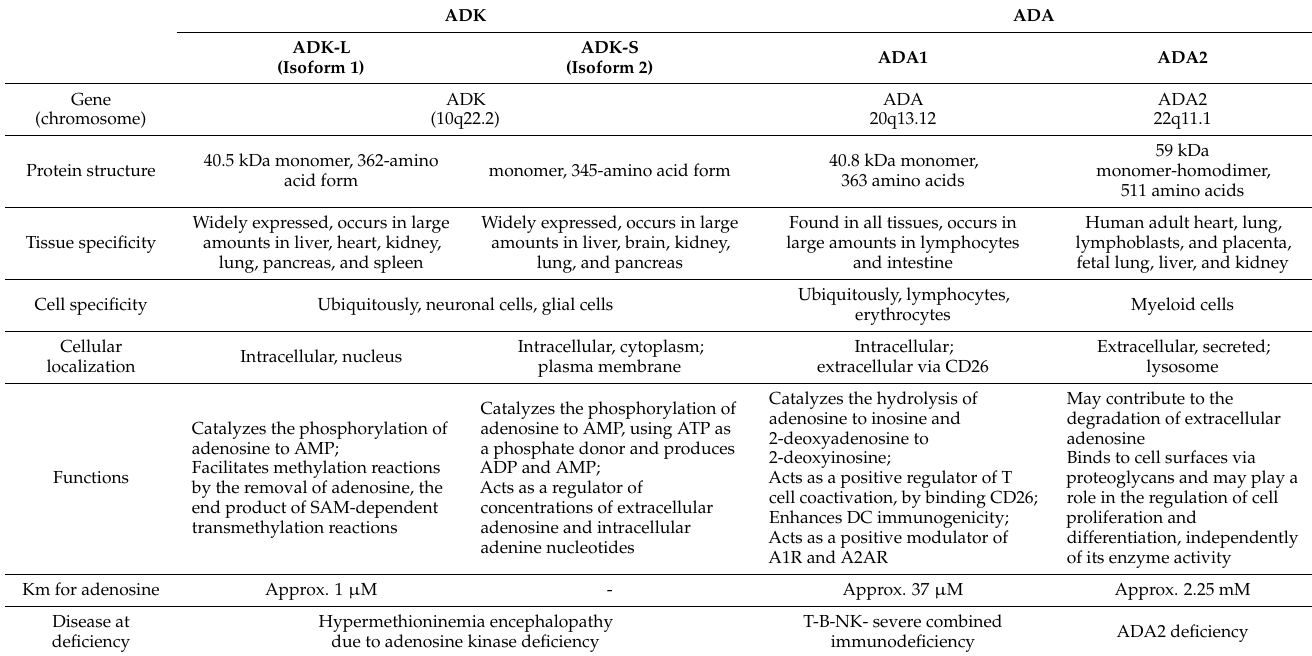
Table 1. Characteristics of ADK isoforms and ADA isoforms